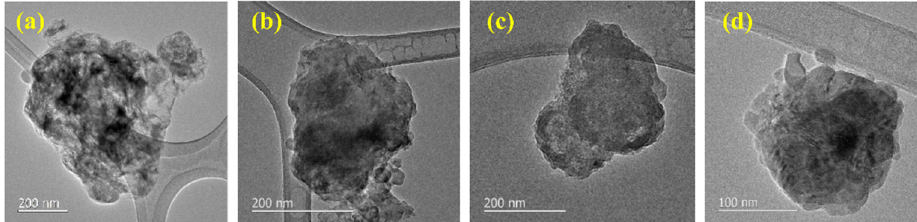
Figure 9. TEM images of Si@void@C particles: ( a ) before cycles, ( b ) after 100 cycles, ( c ) after 200 cycles, and ( d ) after 500 cycles. All cycled particles were obtained after the cells were delithiated up to 1.0 V (vs. Li + /Li).